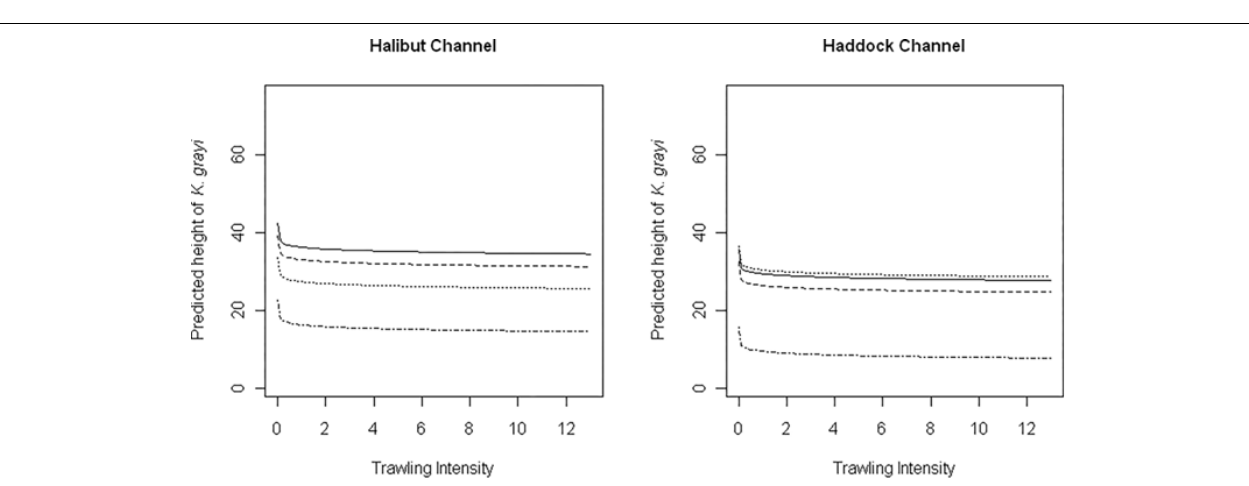
FIGURE 4 | Model predictions of the influence of trawling intensity on Keratoisis grayi height in Halibut and Haddock Channels in boulders (solid), cobble (dotted), gravel (dashed), and outcrops (dot/dash) at mean depth (650 m).